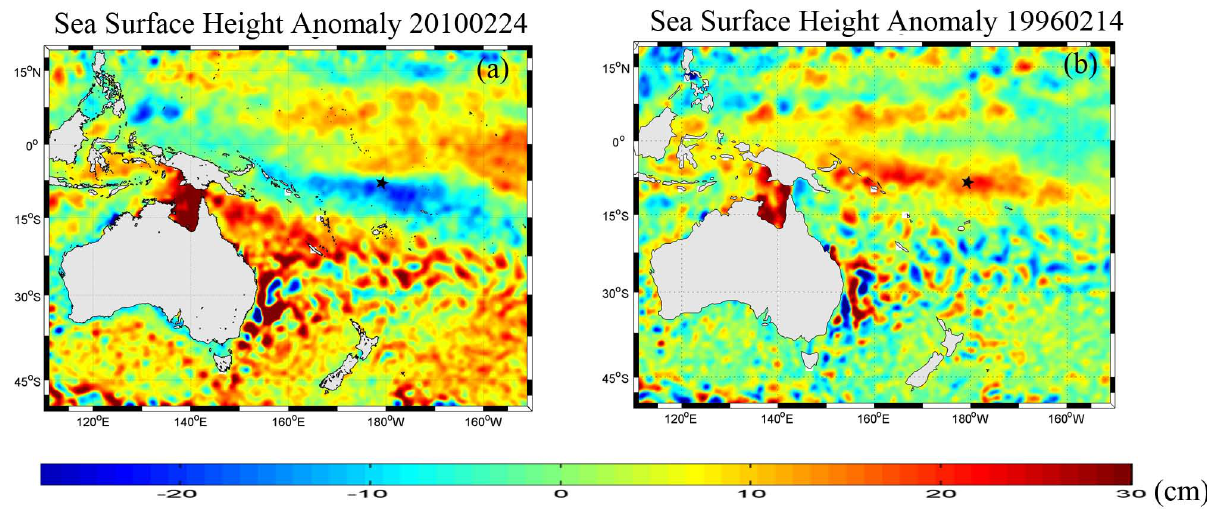
Fig. 8. (a) The image of sea surface height interprets that Chile earthquake did not cause severe regional flooding in Tuvalu under the background of cold water mass. (b) The image displays Tuvalu was flooded under the combination of tsunami surge and warm-water effect. The date on the image of sea surface height anomaly indicated the middle date of the 7